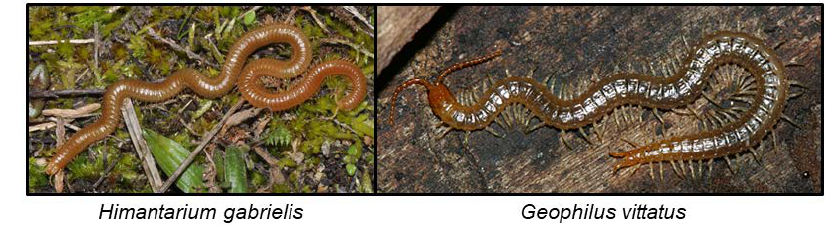
Figure 8. H. gabrielis photo by Pascal Dubois (https://www.galerie-insecte.org/galerie/esp-page.php?